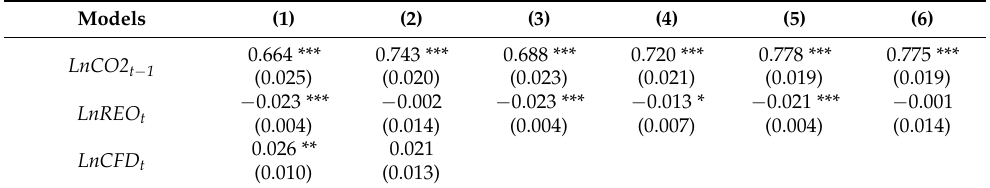
Table 3. Results of GMM model with LnREO and without the squared term of financial development.